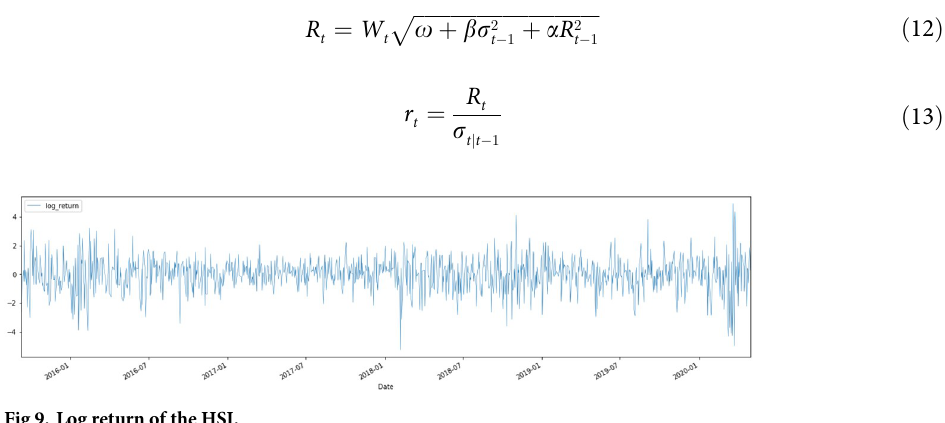
Fig 9. Log return of the